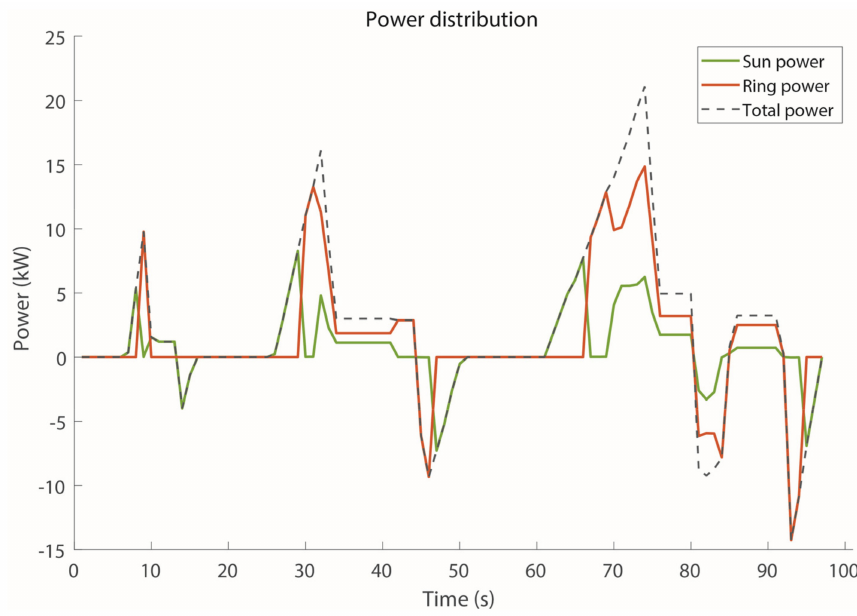
Figure 12. Power split between sun and ring motors in the Artemis DC (first 100